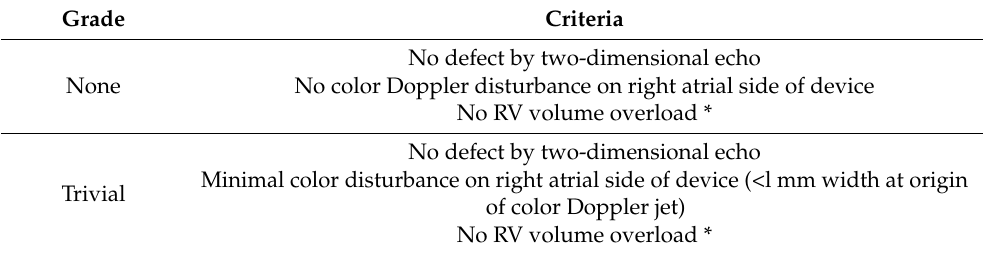
Table 1. Method for classifying left-to-right atrial shunt by echocardiography. Grade Criteria No defect by two-dimensional echo None No color Doppler disturbance on right atrial side of device No RV volume overload * No defect by two-dimensional echo Minimal color disturbance on right atrial side of device (<l mm width at origin Trivial of color Doppler jet) No RV volume overload